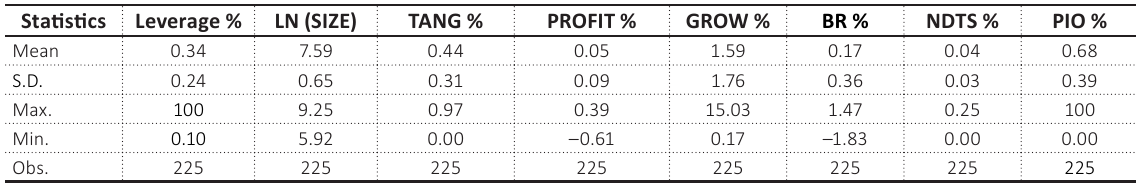
Table 1. Characteristics of Jordanian service